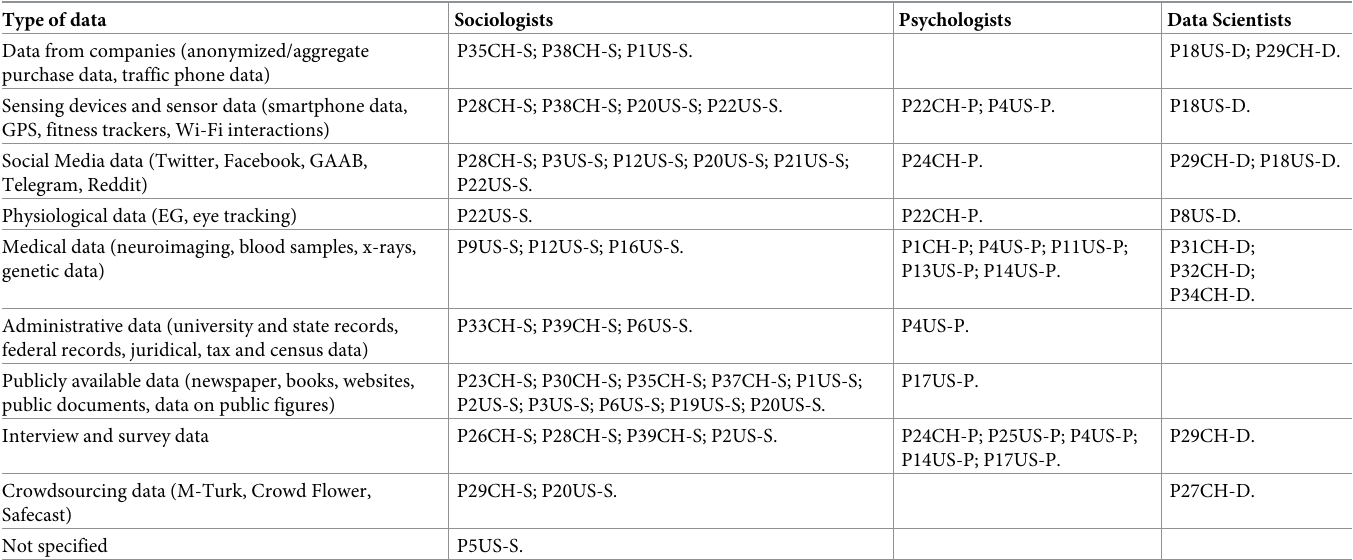
Table 4. Data used by participants.